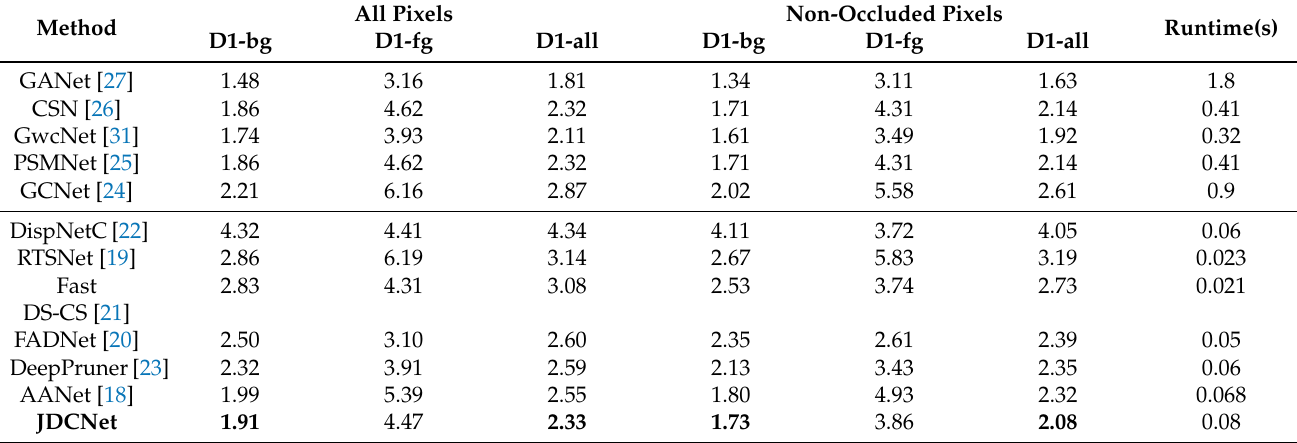
Table 4. The official results on KITTI 2015 benchmark. The first five are classic 3D stereo methods, while the others are fast stereo networks. Bold denotes important metrics or the best results in all fast stereo networks. Compared with other fast methods, our JDCNet can achieve the best performance in D1-bg and the main evaluation metric D1-all for all and non-occluded